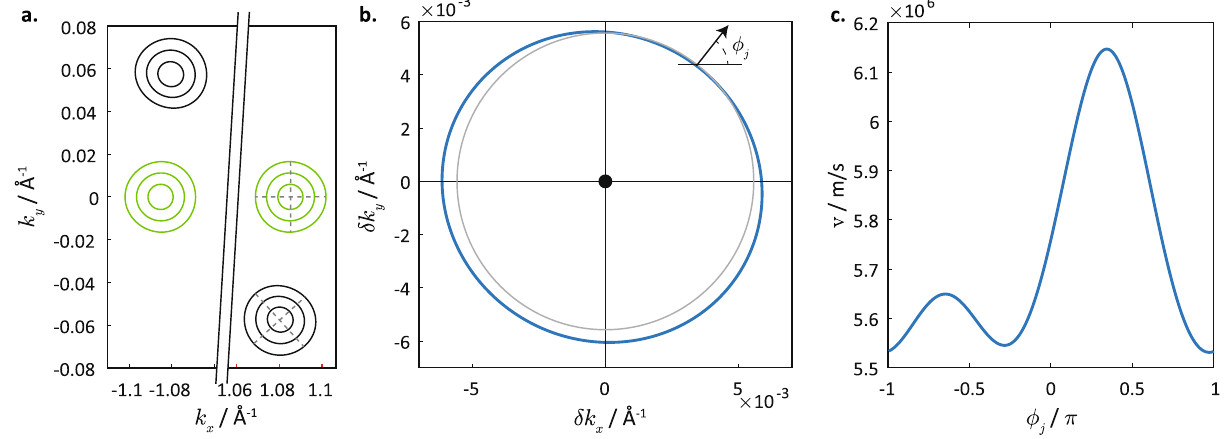
Figure 3. Equal enegy-contours and group velocities of silicene. ( a ) The EECs for strained (black) silicene for strain direction α = 2 and magnitude γ = 1.1 , and unstrained silicene (green). The three contour lines correspond to energies of 20 meV, 40 meV and 60 meV above their respective Dirac points. The grey dotted lines straddling the positive k x EECs denote the major and minor axes of the EECs. ( b ) A close-up of the EEC of strained silicene in the vicinity of the positive k x valley (blue line) at 60 meV above the Dirac point. The EEC lies off-centre about the Dirac point. The thinner gray circle is of uniform radius and centered at the Dirac point to illustrate the anisotropy of the EEC. The angle φ j (depicted at the upper right of the EEC) denotes the direction of the normal to the EEC, which is also the velocity direction corresponding to the state at the k point. ( c ) Plot of the velocity as a function of the velocity direction φ j taken at each k -point on the EEC of strained silicene in ( b